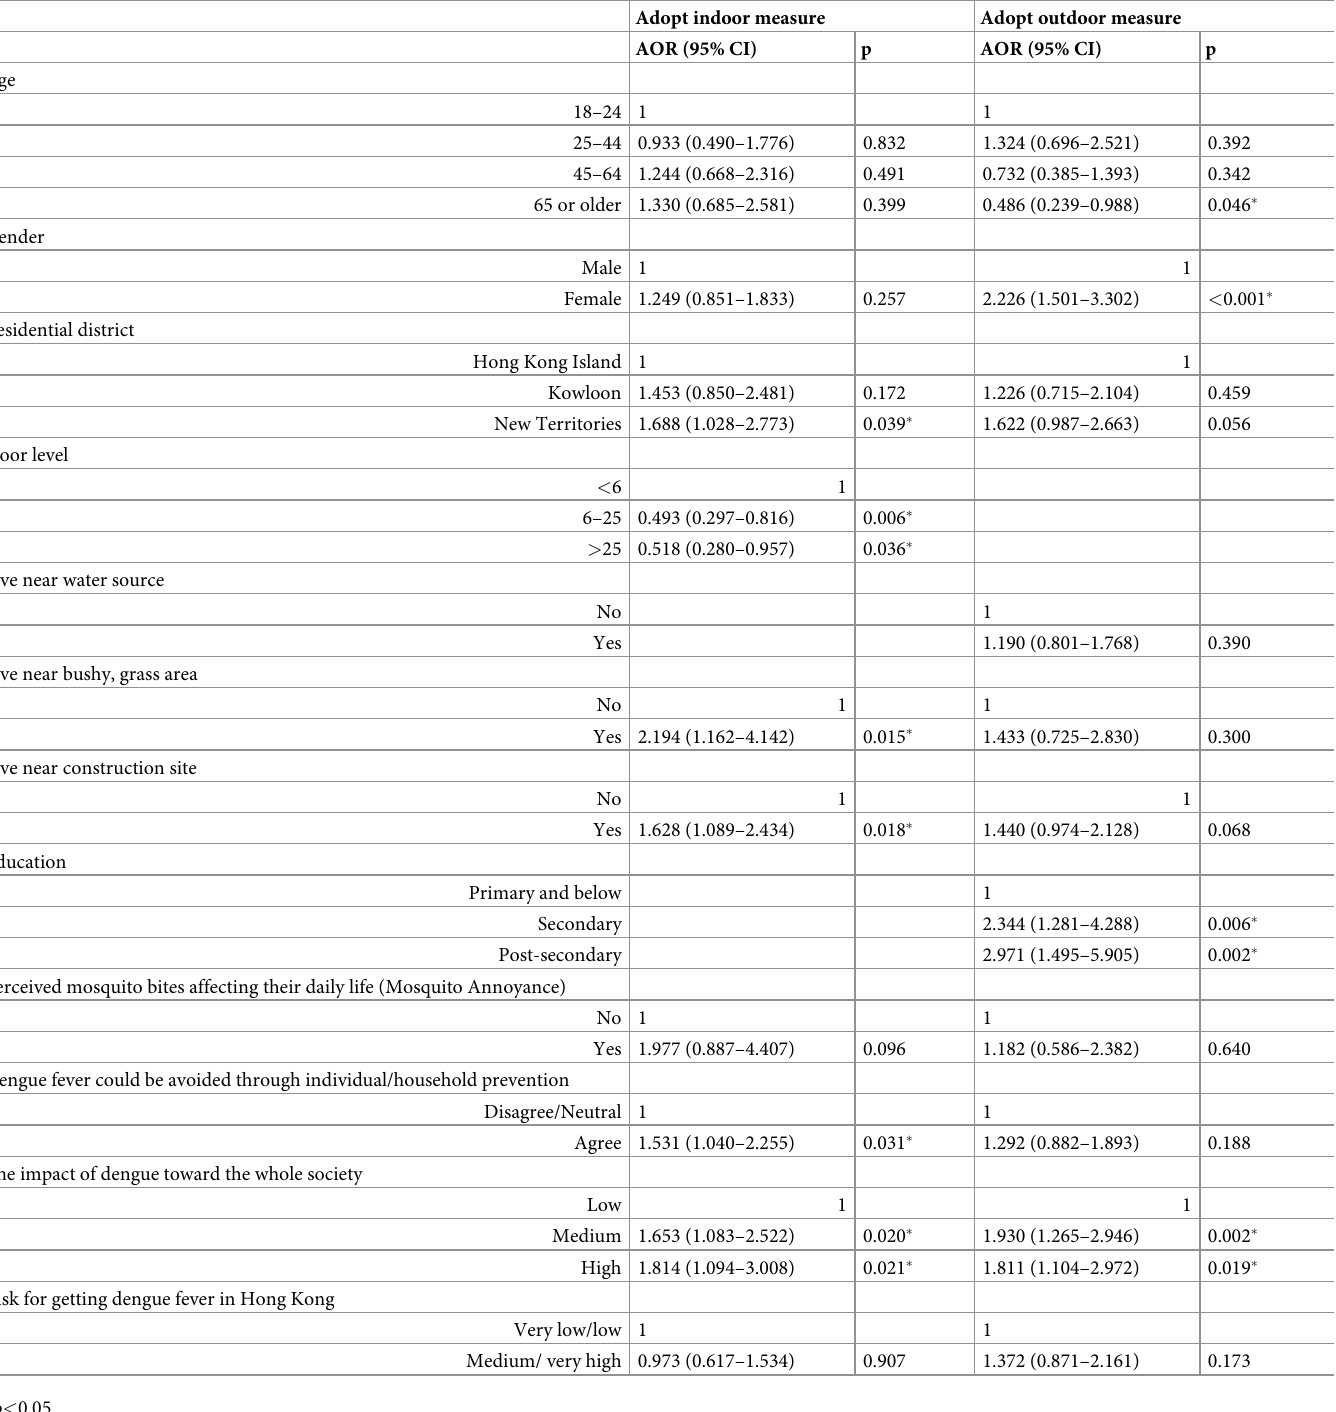
Table 4. Associated factors of the use of indoor and outdoor protective measures against mosquito